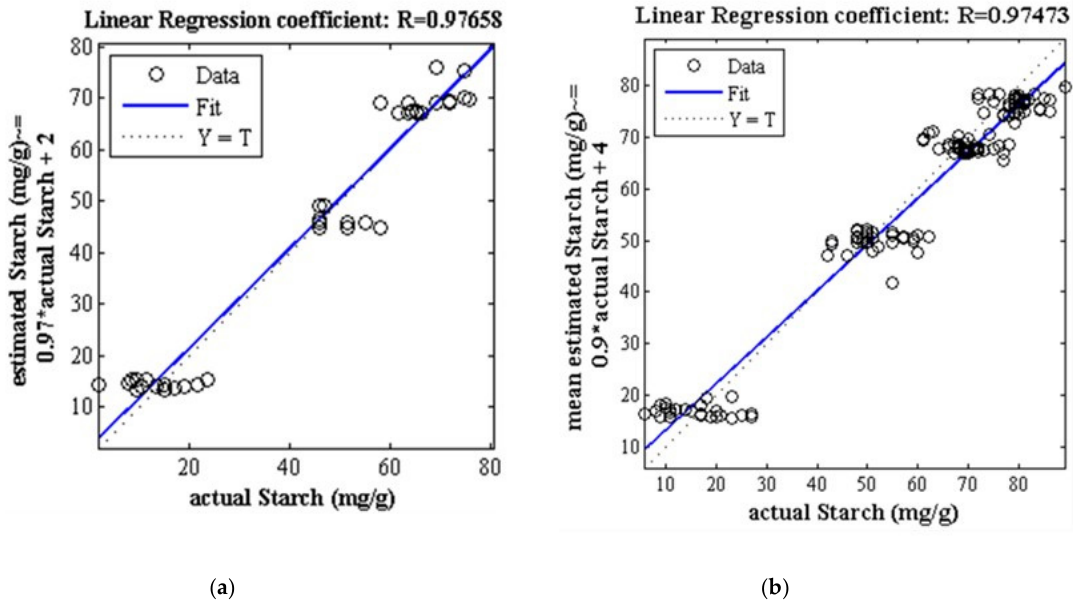
Figure 11. Regression analysis of scatter plot at the best state of training of ANN-BBO to predict starch content of Fuji apple, ( a ) based on spectral data in the range of 800 to 900 nm, ( b ) based on spectral data of the most effective wavelengths. Table 3. Comparison of the mean and standard deviation of criteria of ANN-BBO for estimating starch content of Fuji apple in 100 replicates using spectral data of 800 to 900 nm and data on effective wavelengths.